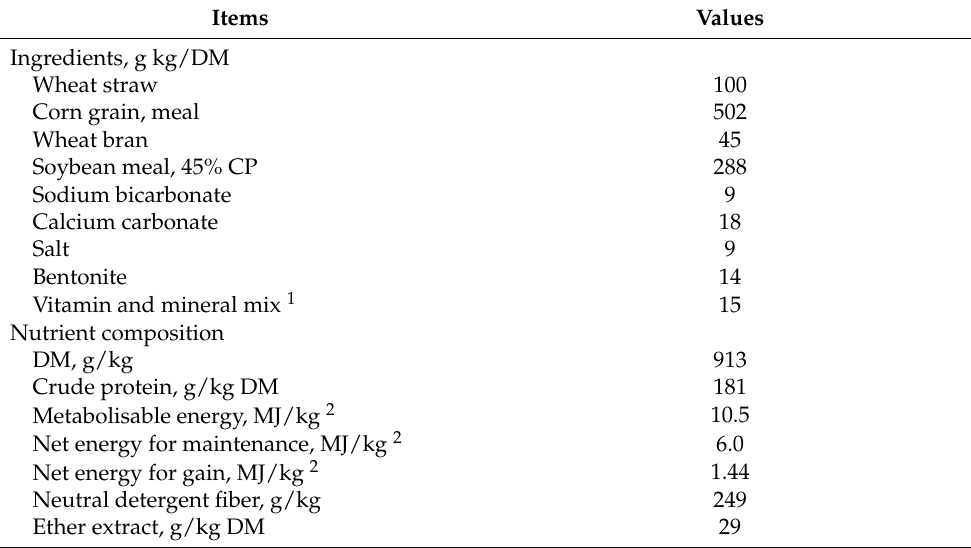
Table 1. Description of starter